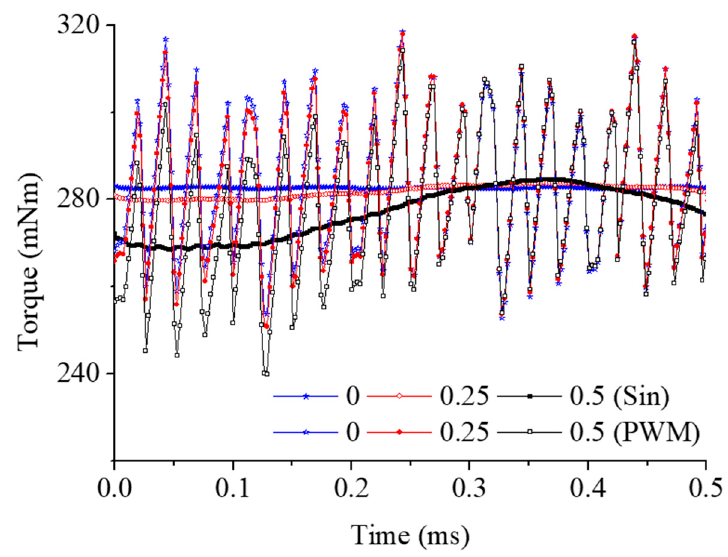
Figure 7. Electromagnetic field analysis results according to eccentricity and current waveforms. Table 6. Comparison of torque, torque ripple, and maximum flux density according to eccentricity and current waveforms.